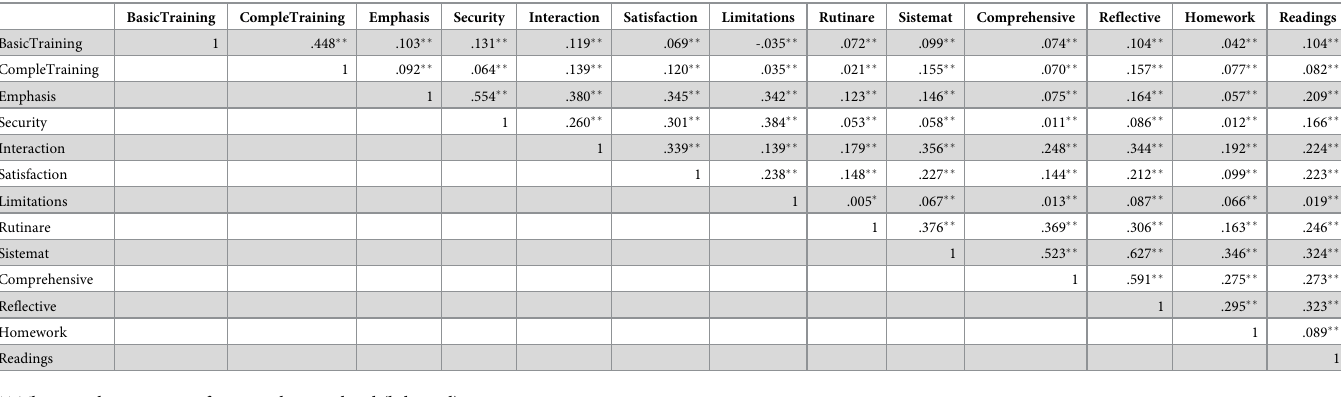
Table 4. Correlations of variables related to